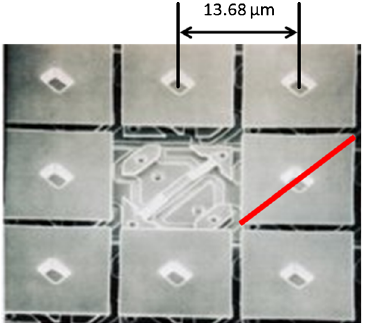
FIG. 1. Image adapted from Texas Instruments. Magnified view of a DMD. In the center, a mirror has been removed, revealing the underlying architecture. Each mirror can be rotated about the diagonal axis indicated in the image. The DMD used in the experiment consists of a 1024 (cid:1) 768 array of mirrors. To make the two stable mirror positions correspond to reflecting incident light horizontally, the DMD is rotated so that the mirror diagonal is perpendicular to the benchtop.